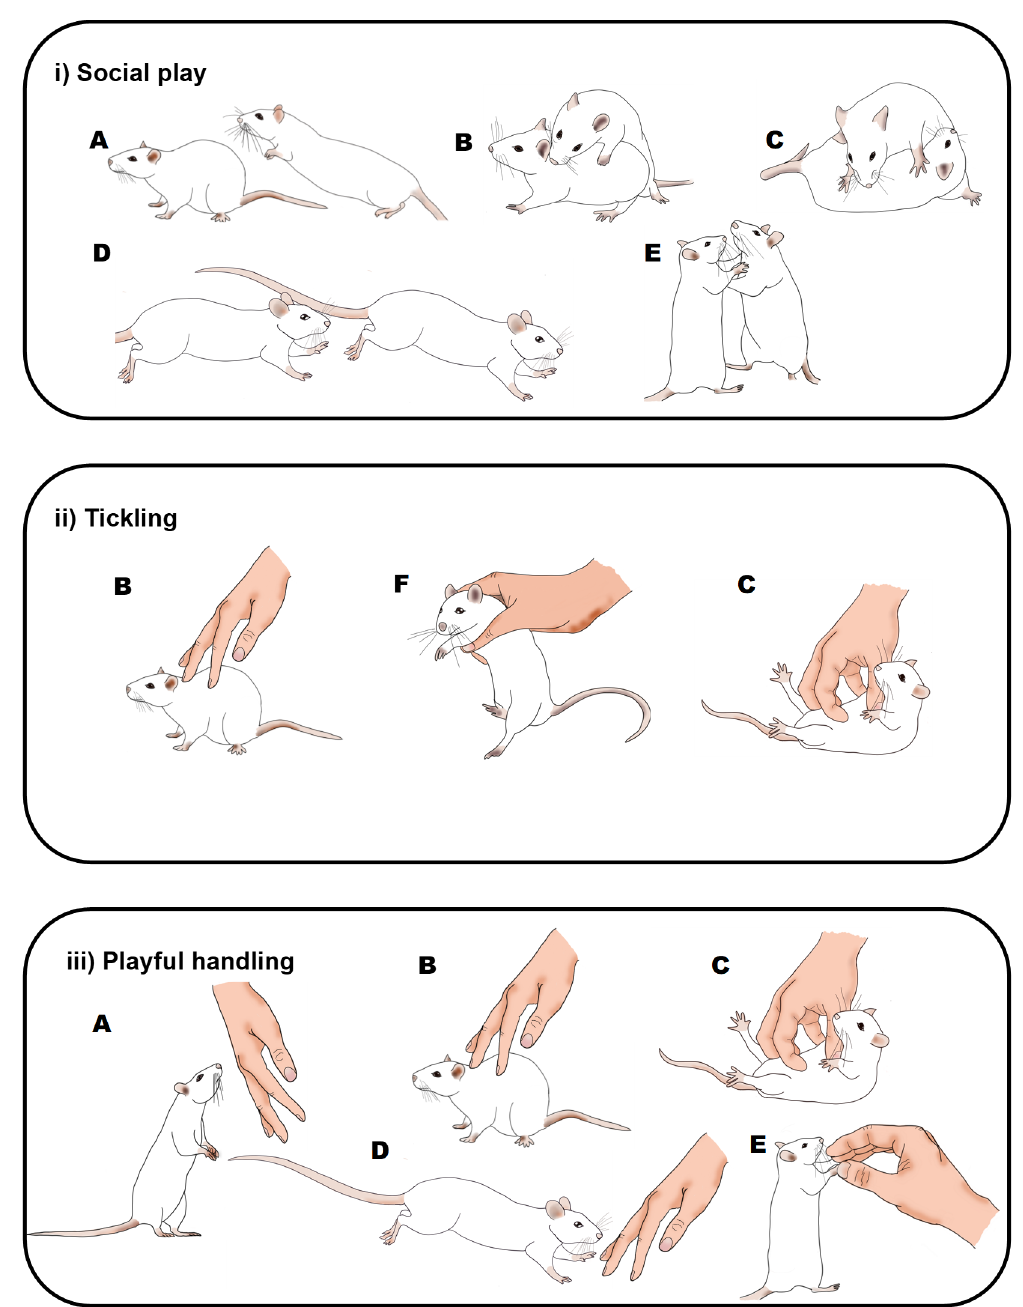
Figure 1. Graphical comparison of playful rat interactions. Illustration of the behaviours seen in rats during: i) social play (Pellis & Pellis, 2013); ii) the Panksepp variation of tickling (Cloutier et al. , 2018); and iii) playful handling (Bombail et al. , 2019, 2021). Letters indicate rat behaviours that share similar or the same physical characteristics: A)pouncing,B)napecontact,C)pinning,D)chasing,E)boxingandF)flipping.Duringsocialplay(i)orplayfulhandling (iii), behaviours can occur in any order and do not always occur in each play bout. During tickling, the sequence of behaviour is always B), F) and then C). Drawings by Tayla Hammond. It is well accepted that rats vary in their response to tickling: The NC3Rs web-site on tickling is clear on this point: “ But I hate being tickled; shouldn ’ t rats hate it too? This is a common concern, and it is true that some rats enjoy it more than others ” (https://www.nc3rs.org.uk/tickling-rats-improved-welfare). We initially developed doubts over aspects of the standard tickling protocol (Bombail et al. , 2019) with its regular use of pinning due to the individual variation in USVs